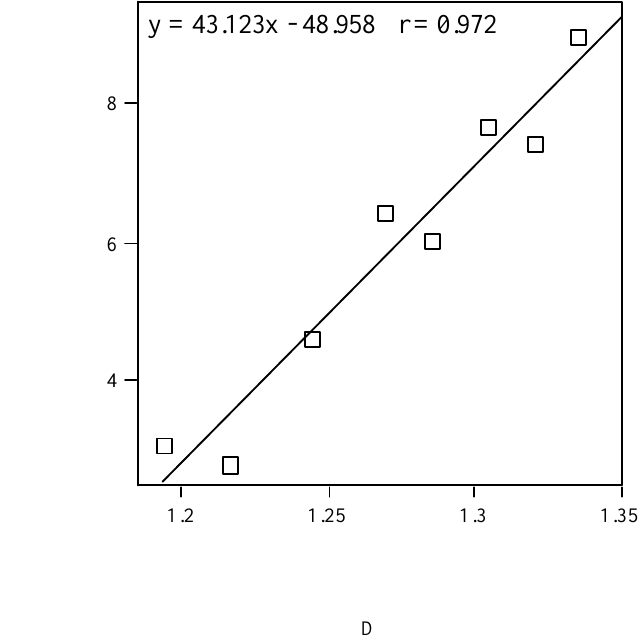
Figure 2. Quadrupole moment of homologous phenyl alcohols vs . the fractal